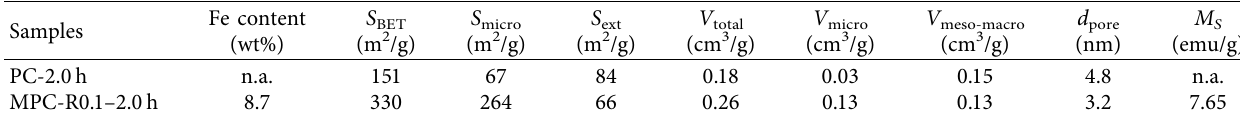
Figure 5: Nitrogen adsorption-desorption isotherm and BJH pore size distribution of MPC-R0.1–2.0h. Table 2: Properties of PC-2.0 h and MPC-R0.1–2.0 h.